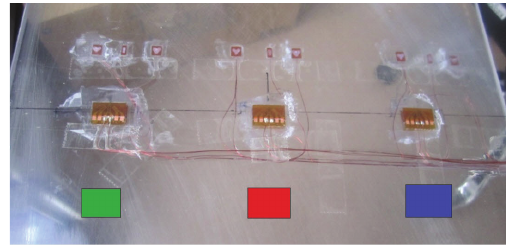
Figure 4: Strain gauge placement for the rectangular plate test.